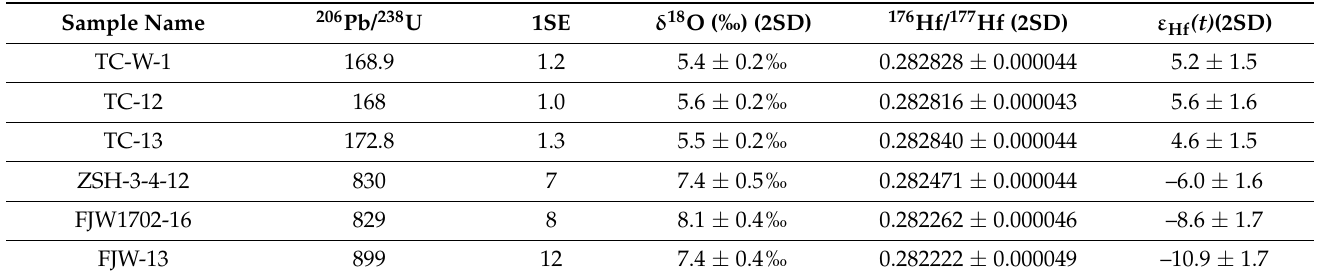
Table 2. Summary of SHRIMP U-Pb ages and Hf-O isotopes of zircon from the Dexing